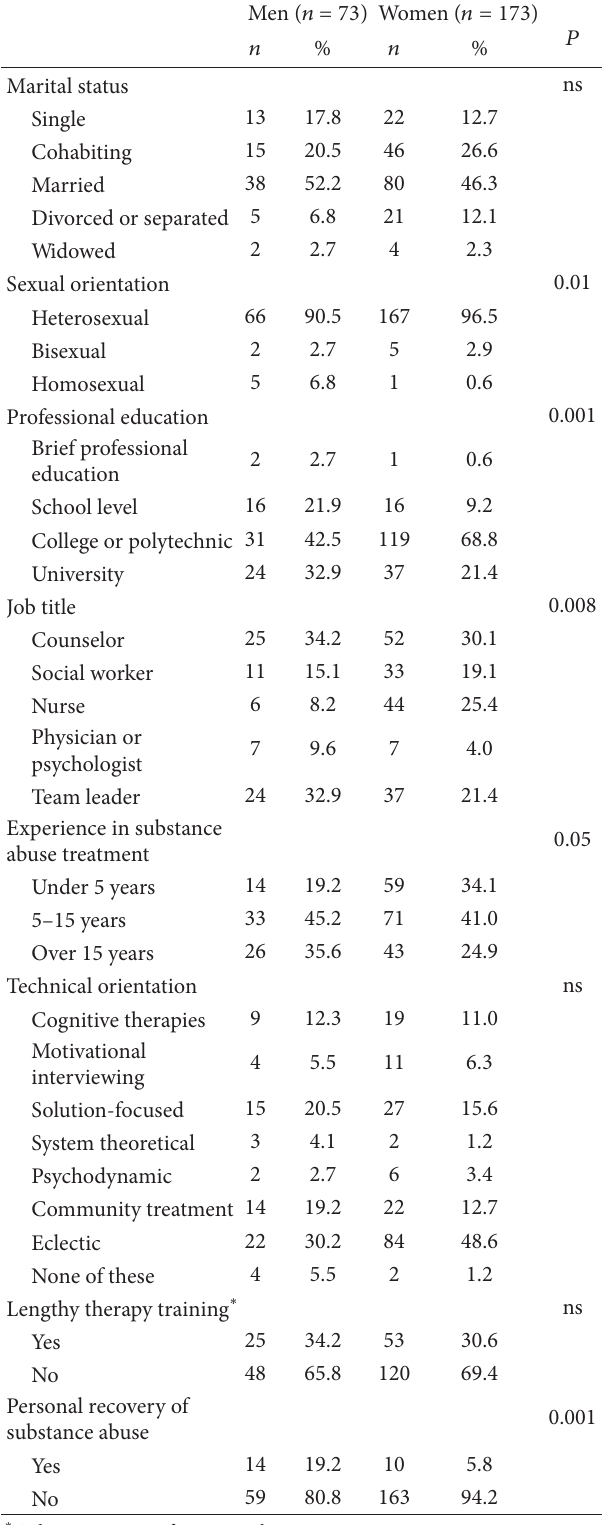
T 1: Background information on therapists by gender. Com- parison